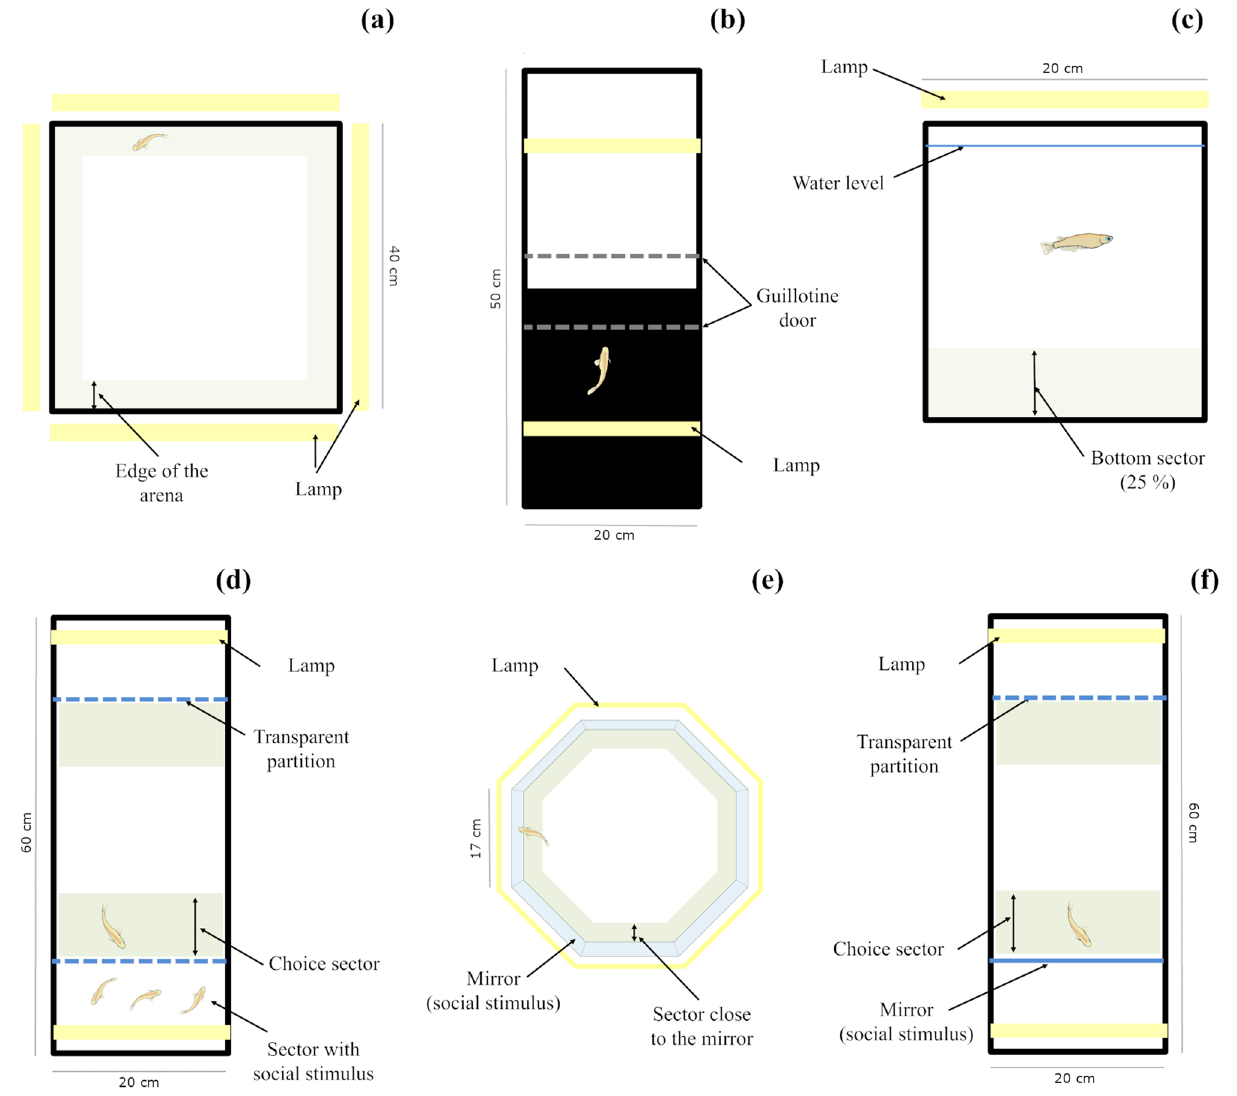
Figure 1. Schematic representations of the experimental apparatuses. ( a ) Open-field test; ( b ) scototaxis test; ( c ) diving test; ( d ) shoaling test; ( e ) octagonal mirror test; and ( f ) shoaling test modified with mirror stimulus. Green shadowing indicates sectors used to analyse fish behaviour; top views, except ( c ): side